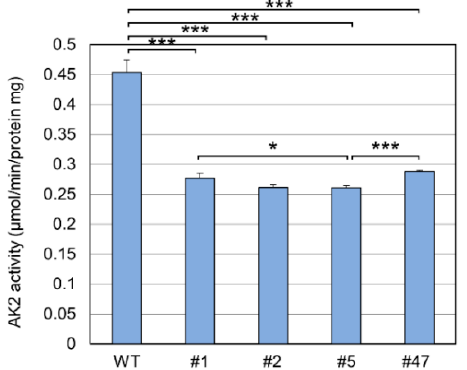
Figure 3. AK2 activity in AK2-deficient clones. AK2 activities of clones were compared with that in WT. Clones #1 and #2 were generated in the first trial. Clones #5 and #47 were generated in the second trial. * p < 0.05; *** p <